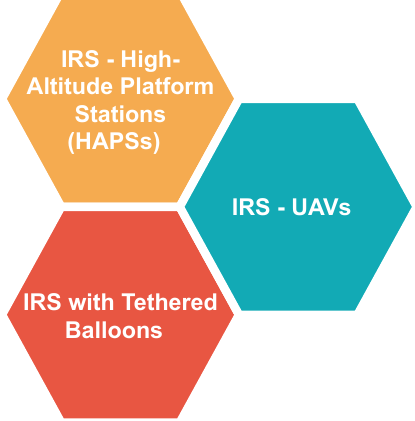
Figure 7. IRS-Assisted Airborne Mobile